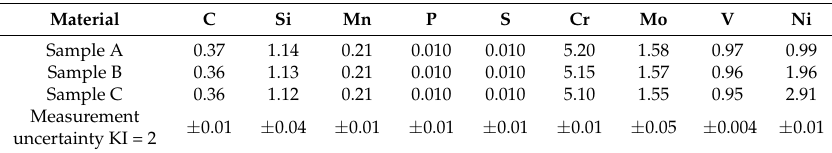
Table 5. Chemical composition of AISI H13 (wt %).